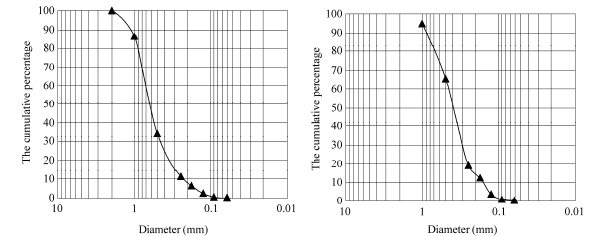
Fig. 4 Coarse sand grading curve. Fig. 5 Fine sand grading curve. Fig. 4. Coarse sand grading curve.